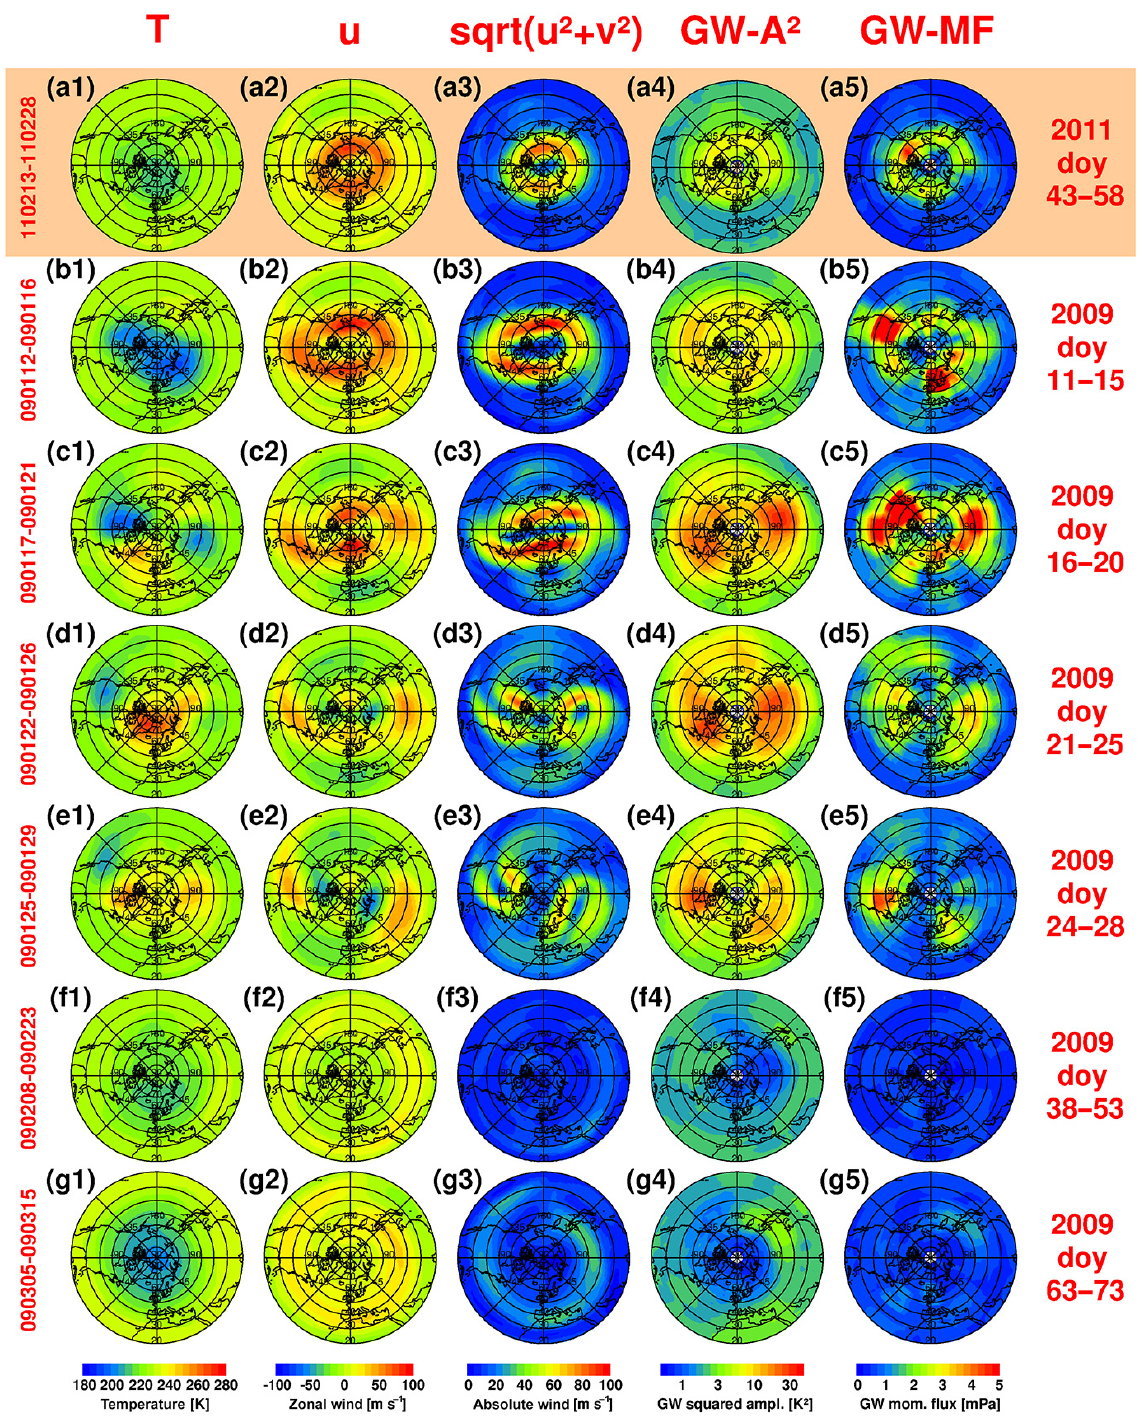
Figure 7. Horizontal distributions at 30km altitude of ERA-Interim temperatures (left column), zonal wind (second column), absolute horizontal wind (third column), and SABER gravity wave squared amplitudes in K 2 on a logarithmic scale (fourth column), as well as SABER gravity wave momentum fluxes in mPa on a linear scale (right column). The first row represents an unperturbed vortex situation, averaged over 13–28 February 2011, while the other rows represent different periods before, during, and after the central date (24 January) of the 2009 major